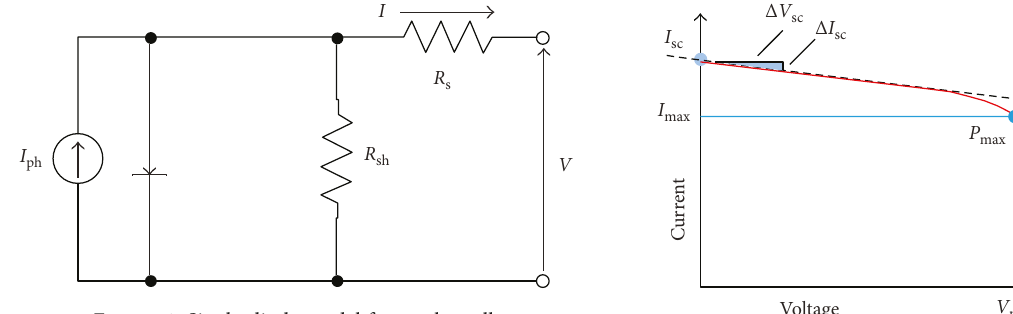
Figure 1: Single-diode model for a solar cell.